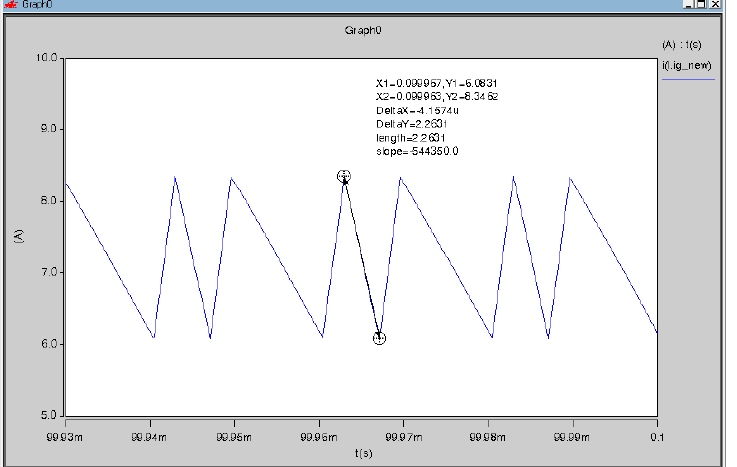
Figure 18. Zoom in the input current ripple for the former strategy when G = 6 . 5, D = 0 . 7994 ( k d = 0 . 5).